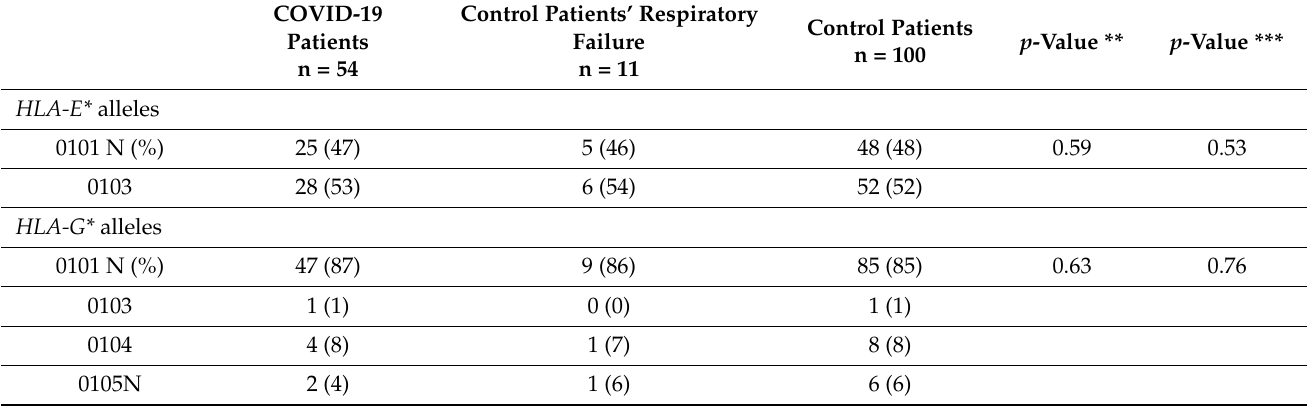
Table 3. HLA-G and HLA-E allelic distribution in COVID-19 patients and controls. COVID-19 Patients